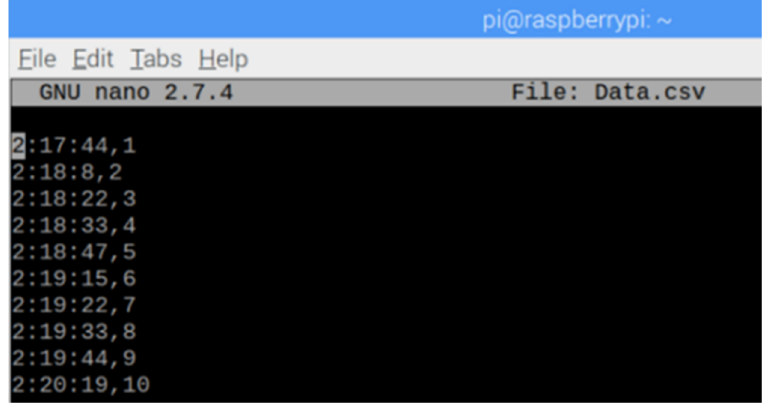
Figure 4. The data file saved locally in Raspberry Pi memory to record the time and amount of people that are detected.